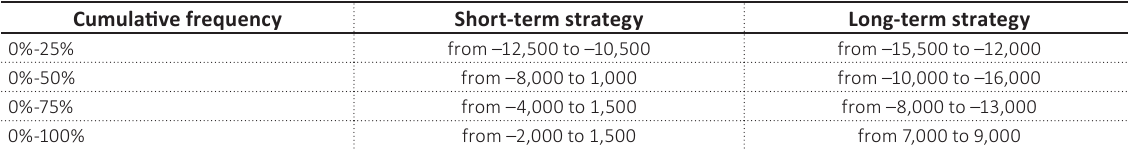
Table 2. Monte Carlo simulation results for short-term and long-term cryptocurrency investment strategies (average profit/loss per one Bitcoin in dollars